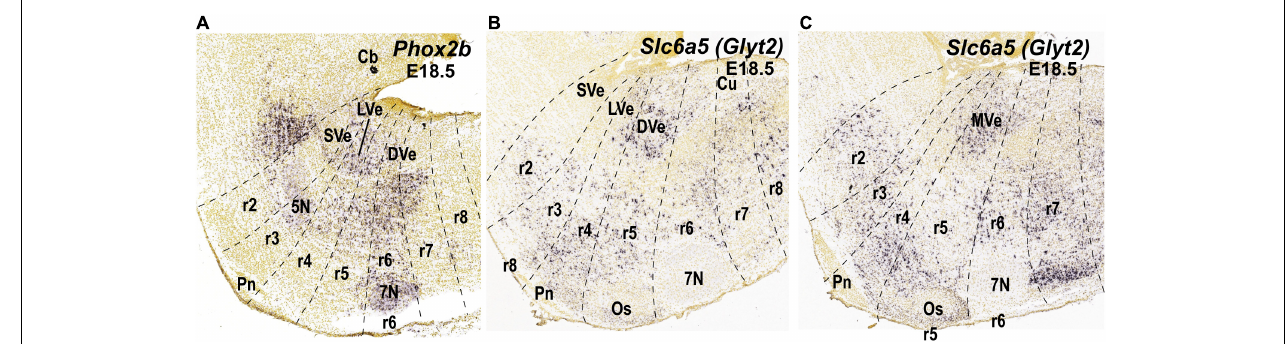
FIGURE 3 | Expression of selected molecular markers in the cytoarchitectonic vestibular nuclei of the mouse according to existing literature in mammals (see main text). Sagittal sections were obtained from ISH data of the Allen Brain platform. Anatomical landmarks with known rhombomeric locations are indicated, and rhombomeres are delimited based on Reference Atlas (Allen Developing Mouse Brain Atlas). (A) Phox2b expression (experiment 100085299; image 7 of 18); (B,C) Slc6a5 expression (experiment 100057240; images 10 and 11 of 19, respectively). 5N, motor trigeminal nucleus; 7N, facial nucleus; Cb, cerebellum; CbN, cerebellar nuclei; Co, cochlear column; Cu, cuneate nucleus; DVe, descending vestibular nucleus; LVe, lateral vestibular nucleus; LVe (d), lateral vestibular nucleus (dorsal Deiter´snucleus); LVe (v), lateral vestibular nucleus, ventral part; MVe, medial vestibular nucleus; Os, superior olive; Pn, pontine nuclei; r, rhombomere; SVe, superior vestibular